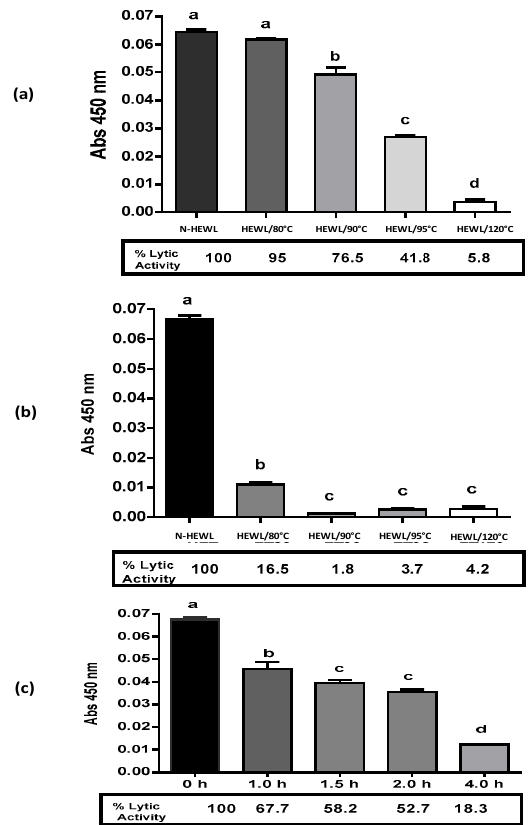
Figure 2. Lytic activity of modified hen egg white lysozyme (HEWL) by heat and chemical treatment. ( a ) Heat treatment HEWL at pH 6.0, native HEWL (N-HEWL), ( b ) heat treatment HEWL at pH 7.0, N-HEWL, and ( c ) HEWL treated with DTT for 0 h, 1.0 h, 2.0 h, and, 4.0 h of incubation. Data are expressed as the mean ± standard deviation ( n = 3). Different letters present significant differences ( p < 0.05) in ANOVA and Tukey’s test.